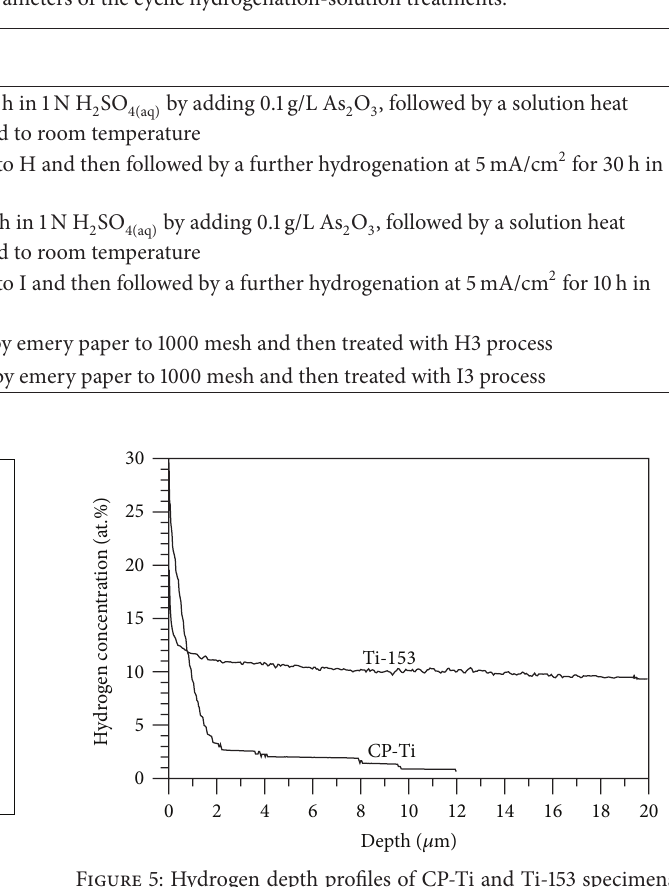
Figure 5: Hydrogen depth profiles of CP-Ti and Ti-153 specimens after cyclic hydrogenation and subsequent solution heat